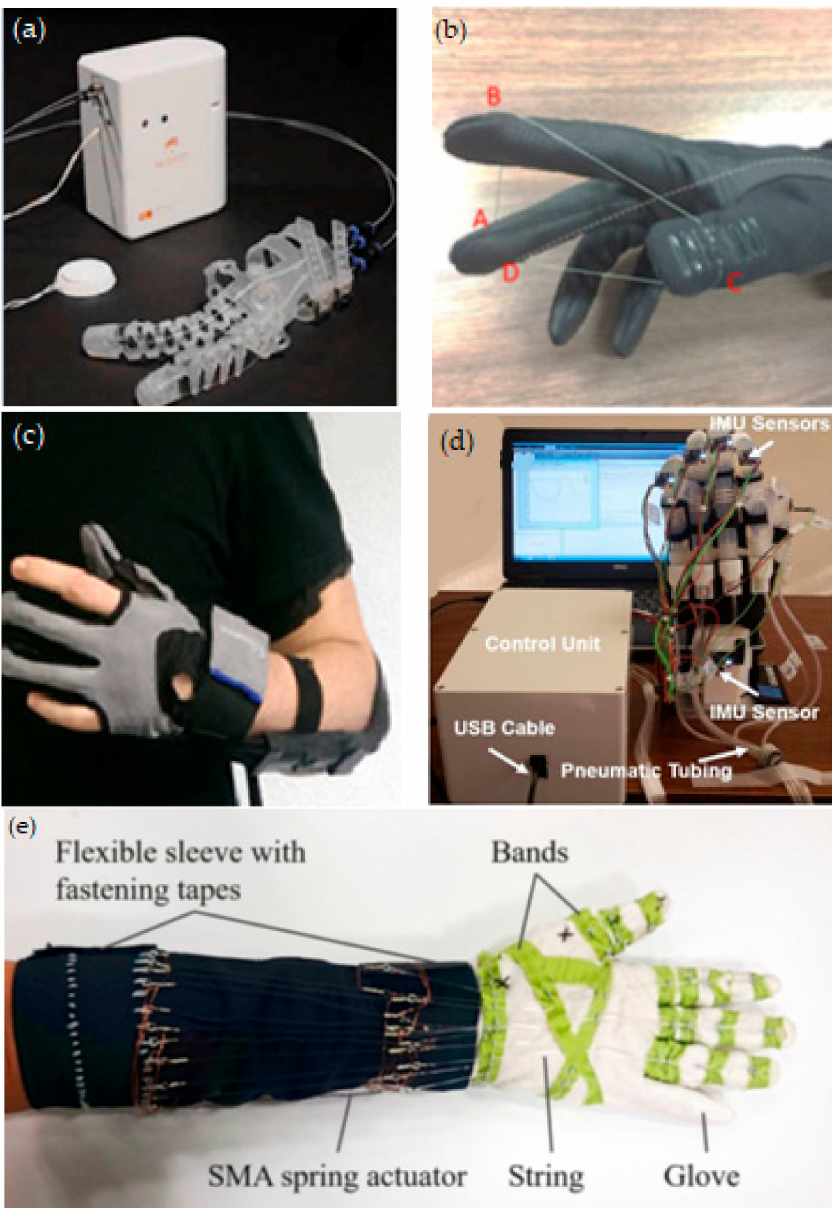
Figure 2. Soft wearable gloves for rehabilitation and ADL. ( a ) Exo-Glove Poly 2.0 (improved version). Reprinted from [52] with permission from Springer Nature. ( b ) Three fingered GRIPIT with a single actuator with cable routing across the point ‘A to D’ indicated in red. Reprinted with permission from [23] published under the Creative Commons Attribution license (CC BY 4.0) [78]. ( c ) The iHand system. Reprinted from [59] with permission from Springer Nature. ( d ) Jarayani glove bending with control unit, Inertial Movement Unit (IMU) sensor and Universal Serial Bus (USB) cable. Reprinted from [48] with permission from IEEE. ( e ) Prototype of the muscle glove using shape-memory alloy (SMA) spring actuators. Reprinted from [74] with permission from Springer